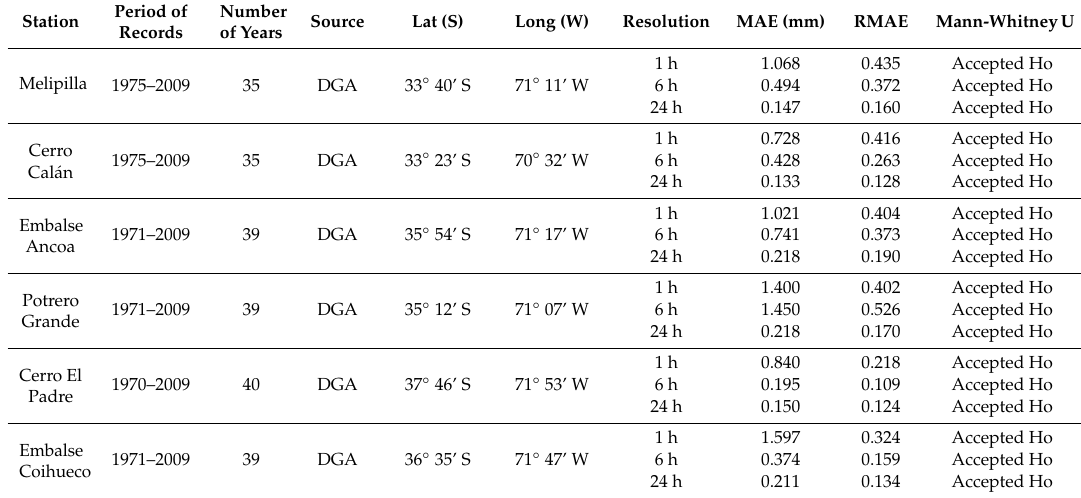
Table 2. Error measures calculated for the rain gauges in central Chile with the longest rainfall intensity records. The error represents the di ff erence between manual readings and digital PSCR readings. DGA: General Directorate of Water